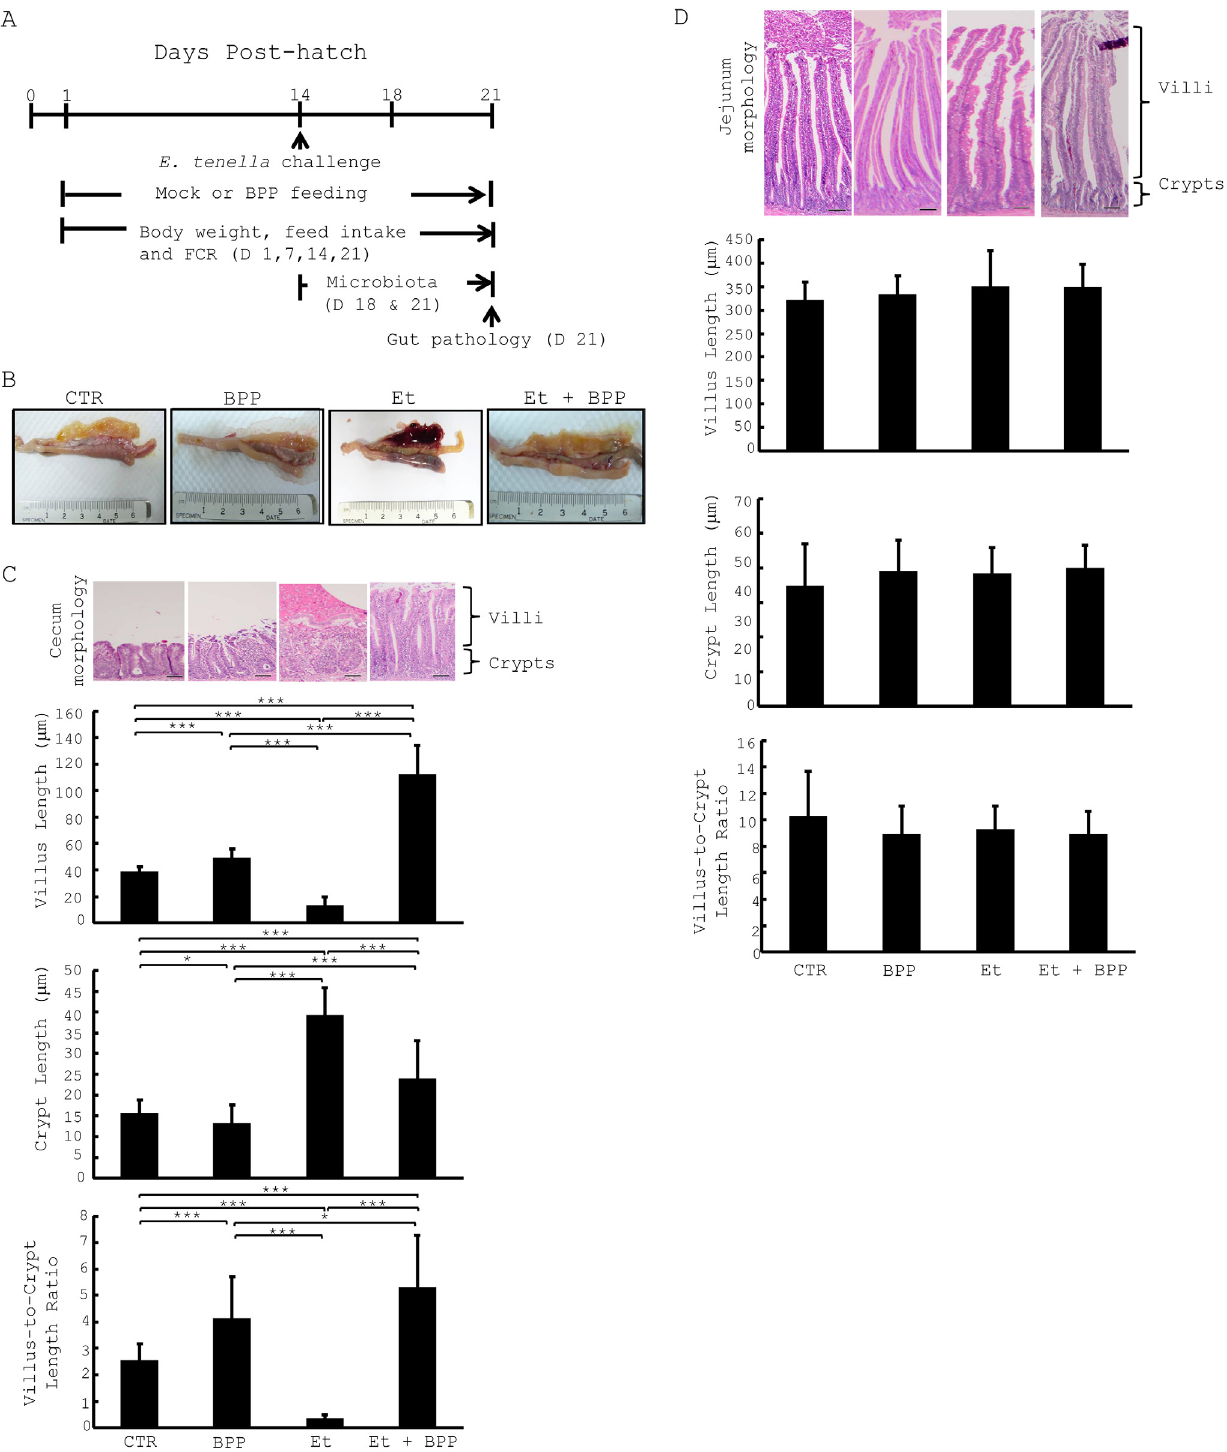
Fig 1. B . pilosa alleviates E . tenella -mediated gut pathology in chickens. (A) Summary of experimental protocol for this study. (B) Representative images of the gut of 21-day-old chickens in each group are shown. (C-D) Hematoxylin and esosin (H&E) staining of the ceca (C) and jejuna (D) of the same chickens as